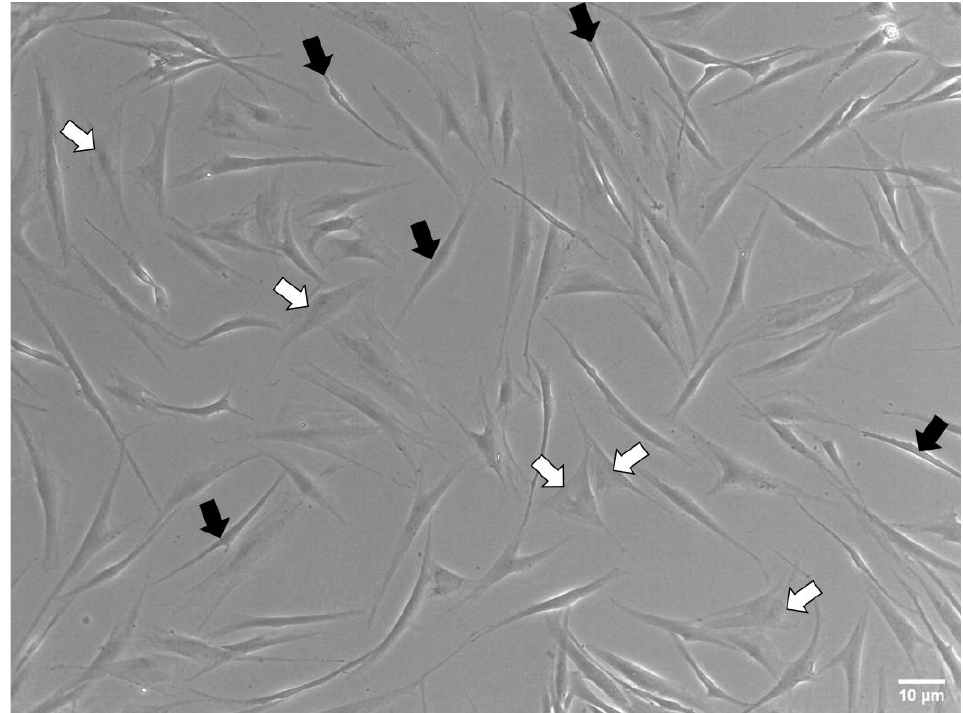
Figure 8. Fibroblast sub-populations. Phase-contrast images highlighted the presence of two different morphological populations: elongated fibroblasts (highlighted with black arrows) and flat fibroblasts (highlighted with white arrows).